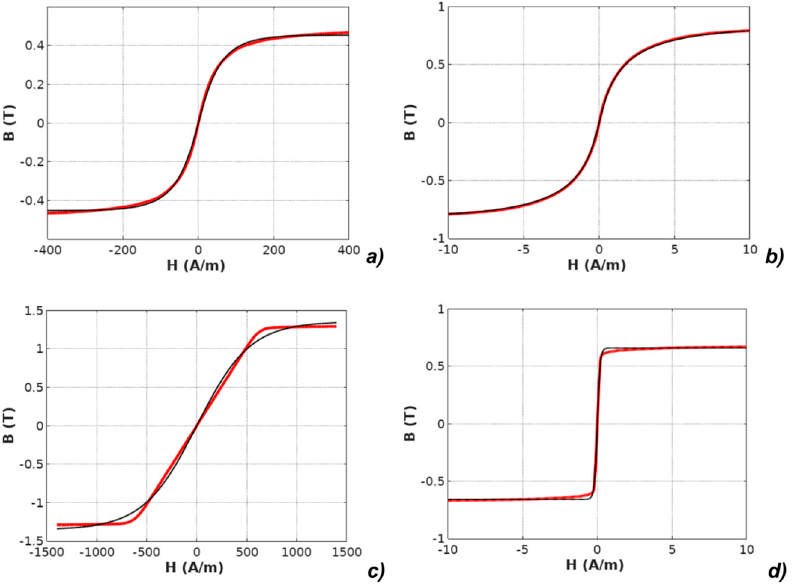
Figure 4. Results of modeling the anhysteretic curve using the exp-based function (measurements: red line, modeling: black line): ( a ) Mn-Zn ferrite F3001, ( b ) Co 67 Fe 4 Mo 1 B 11 Si 17 amorphous alloy, ( c ) Fe 73.5 Cu 1 Nb 3 Si 15.5 B 7 nanocrystalline alloy with perpendicular anisotropy, ( d ) Fe 67 Co 18 B 14 Si 1 amorphous alloy with parallel anisotropy.